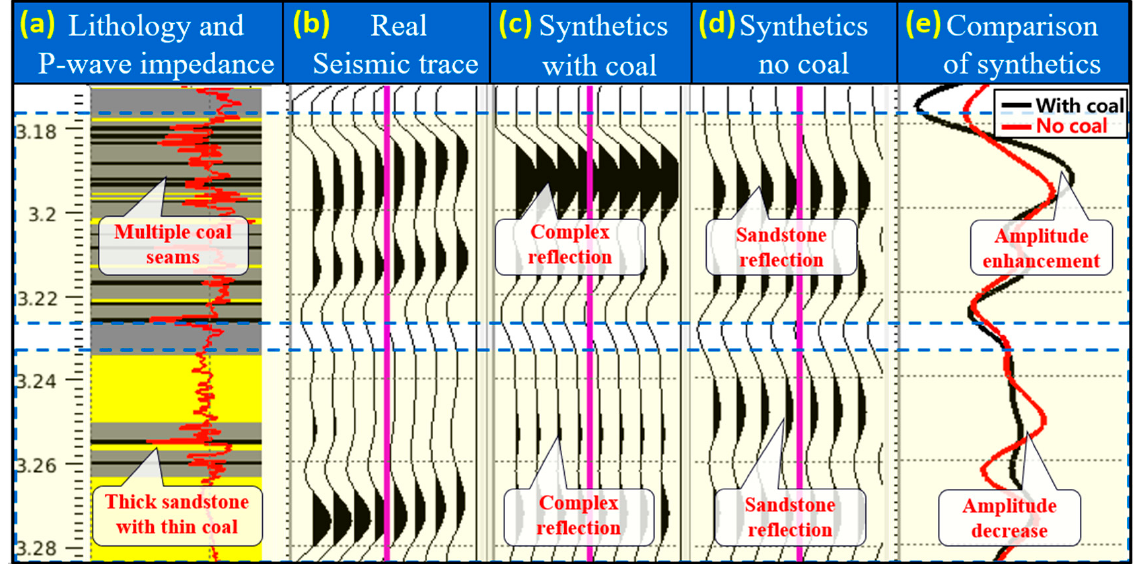
Figure 15. Lithologic results of well logs and comparison of seismic records: ( a ) lithology and P-wave impedance, ( b ) real seismic trace, ( c ) synthetics with coal, ( d ) synthetics without coal, and ( e ) comparison of synthetics.